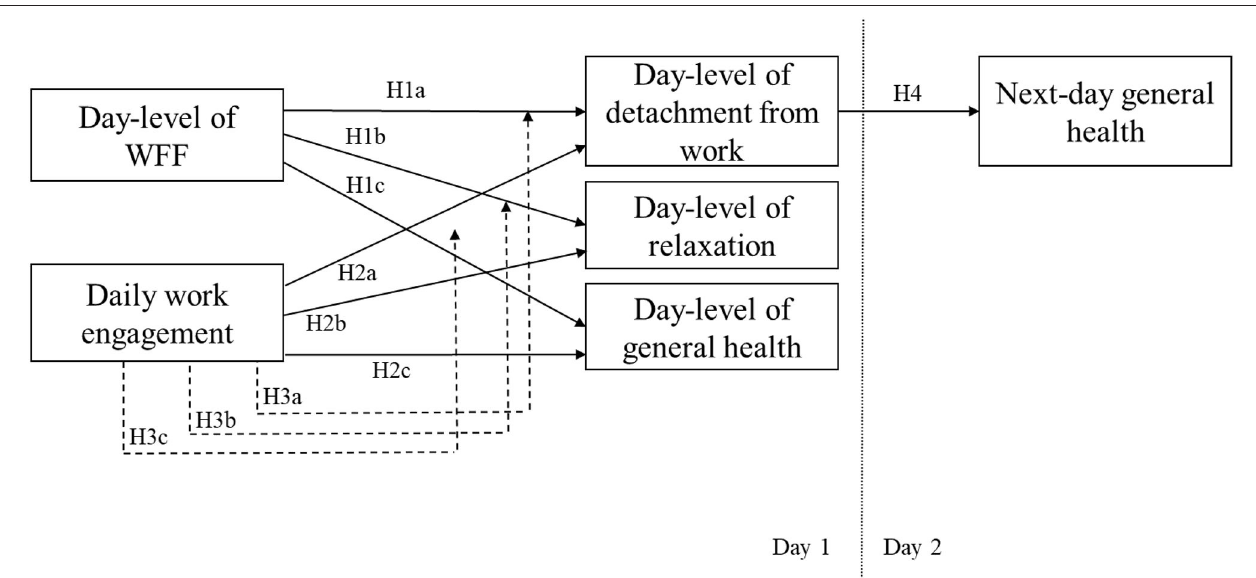
FIGURE 1 | Research day-level model for testing hypotheses within the same and